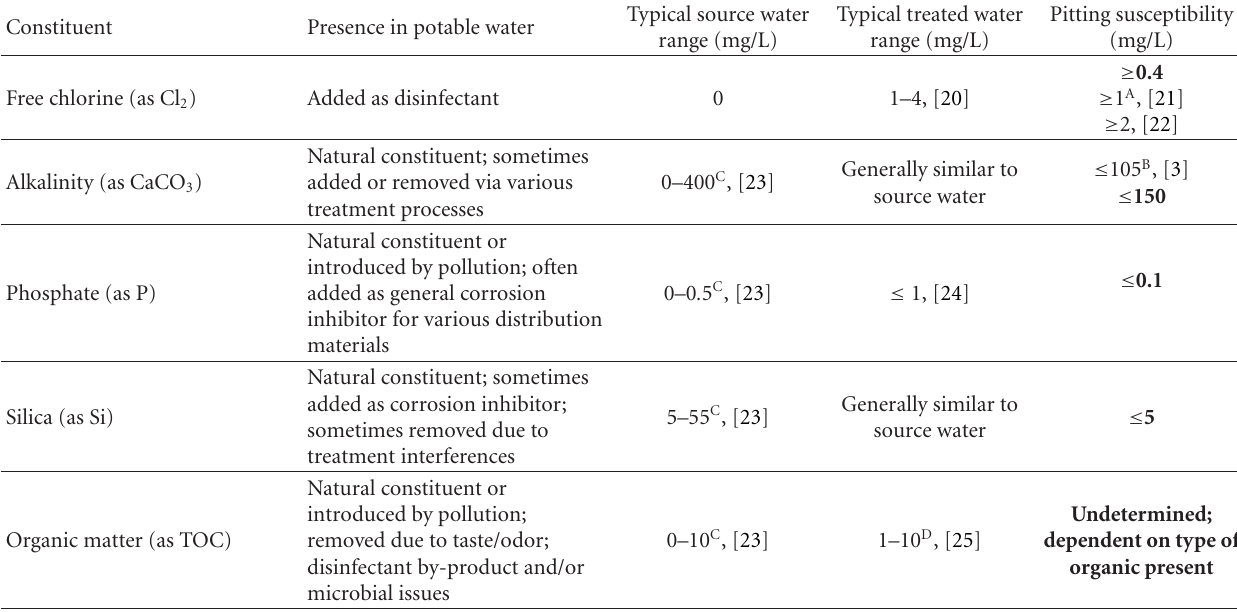
Table 1: Typical ranges of constituents in source and treated waters, and ranges in which copper may be susceptible to pitting in chlorinated, high pH, and low alkalinity water. Bolded values correspond to observations in the current